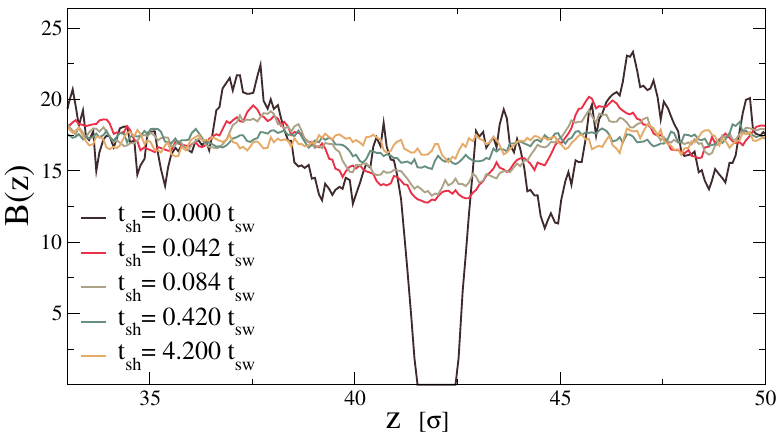
Figure 3. Elastic plateau for different t sh along three orthogonal directions, reported with their standard error. Because our simulations cover a finite amount of time, we see some remaining elasticity even without any healing ( t sh = 0). The xy component is not affected by the cut or the healing process because it measures the resistance to shears in planes parallel to the cut. The xz and yz components denote the build-up of mechanical stiffness during healing/adhesion. In ( b ), we see the cumulative = (cid:82) dG ( G ) that clearly shows the difference between directions perpendicular and function G c ij P ij ij orthogonal to the cut. Already around t sh = 0.1 τ sw , the three components are comparable and thus, the network is capable of sustaining stress across the cut almost as the bulk. They become indistinguishable before reaching 1 τ sw .